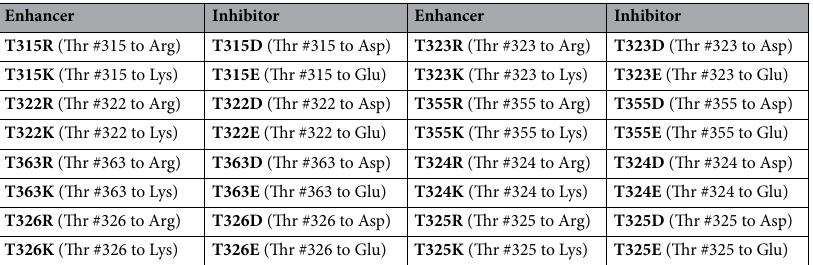
Table 9. Threonine (Thr/T) amino acid mutants.